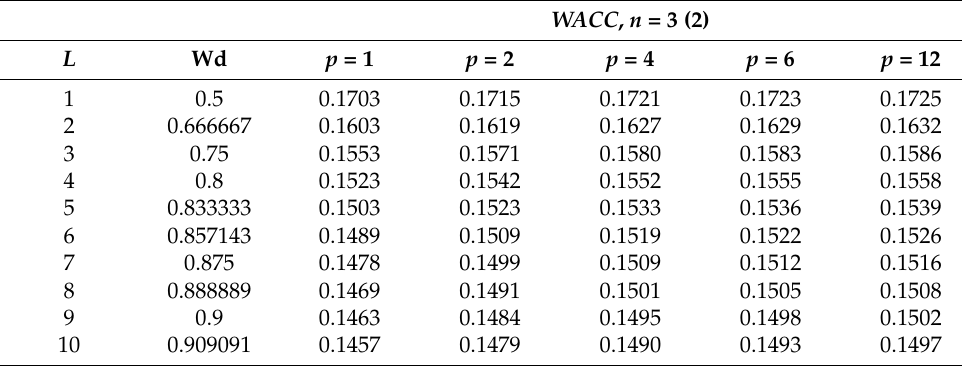
Table 1. The dependence of the WACC on the leverage level ( L ) of a three-year-old company for advance profit tax payments with frequencies of p = 1, 2, 4, 6 and 12.